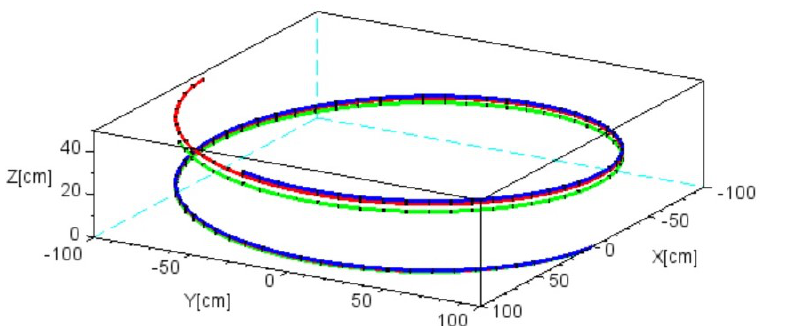
Figure 17. Trajectories of the three quadrotors in Experiment 3. Color code: red, green and blue correspond to leader, mid and rear